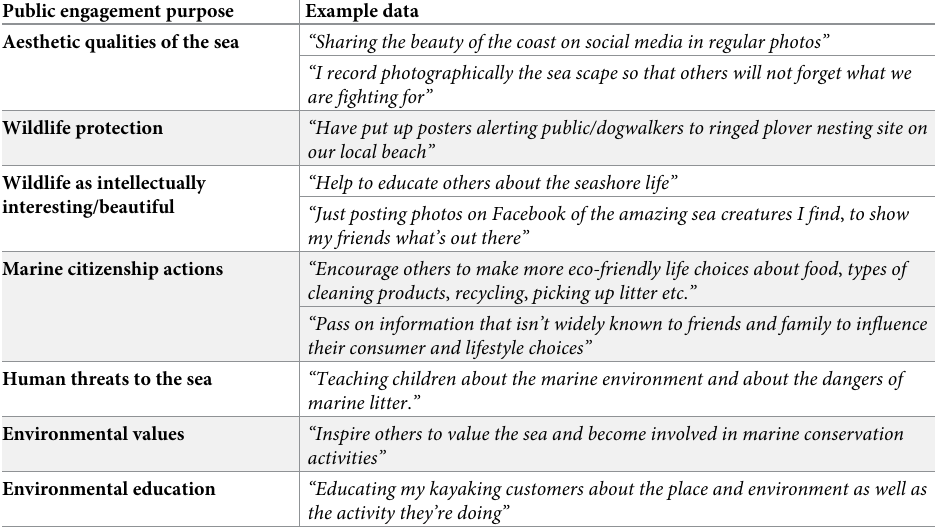
Table 3. Public engagement as marine citizenship. Examples of qualitative data relating to public engagement as an action of marine citizenship, as cited by a population of active marine